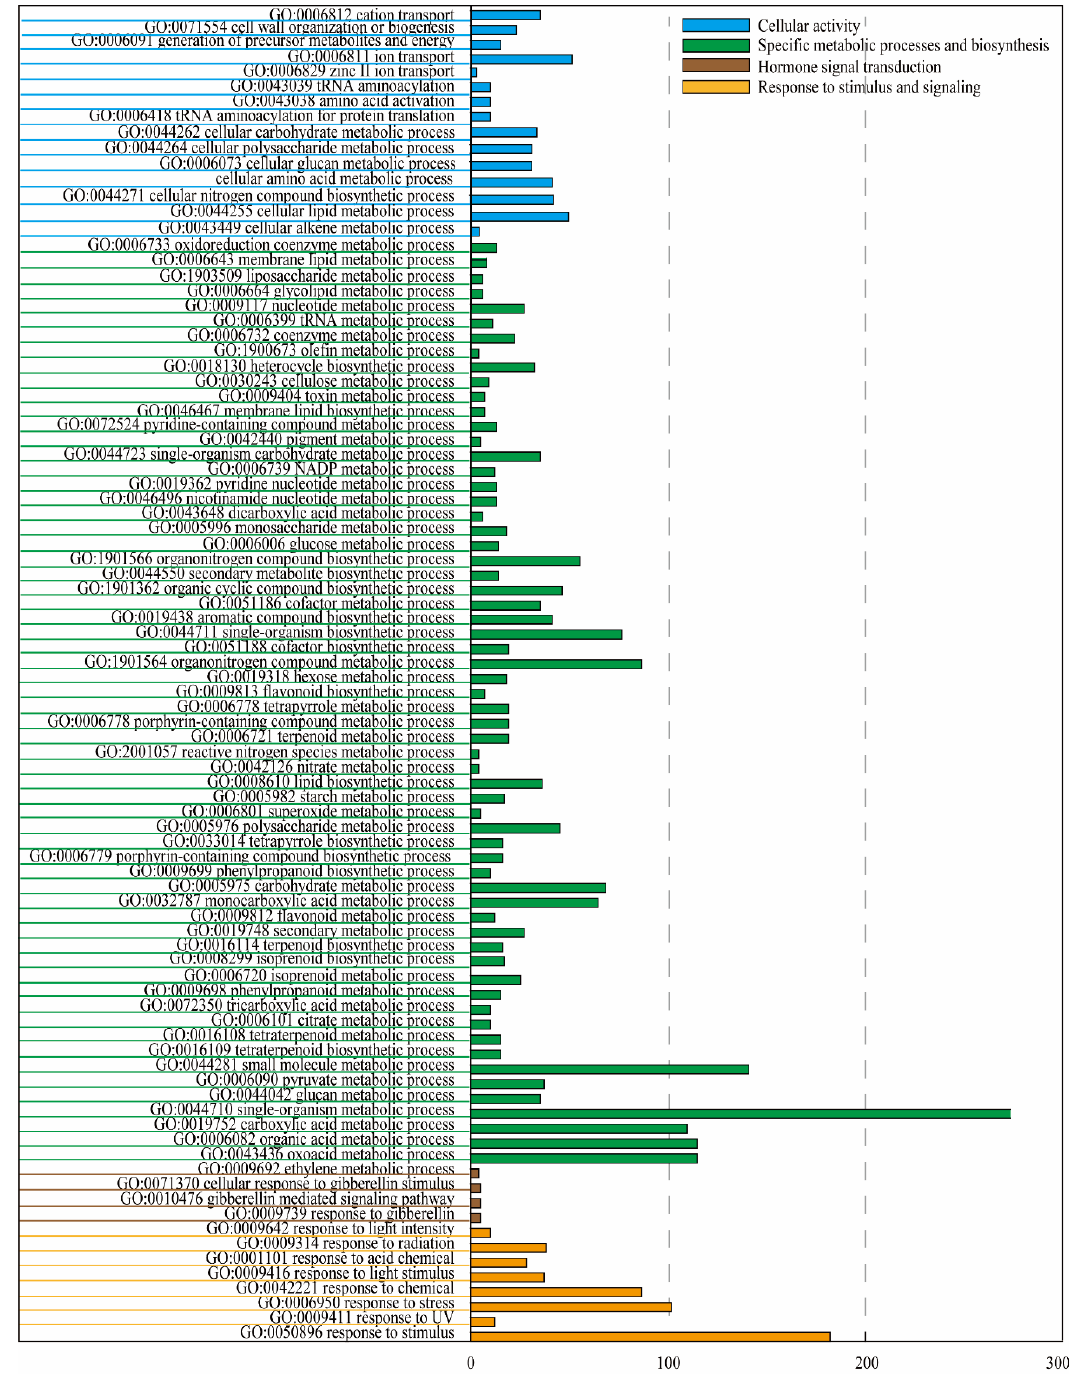
Figure 3. Clusters of annotated Gene Ontology (GO) terms in the “biological process” category enriched in 3281 DEGs in “Granny Smith” apple skins. DEGs were classified into specific “biological process” categories using DAVID (available online: https://david.ncifcrf.gov) with high classification stringency ( p < 0.05). The horizontal ordinate represents the number of genes in the category.